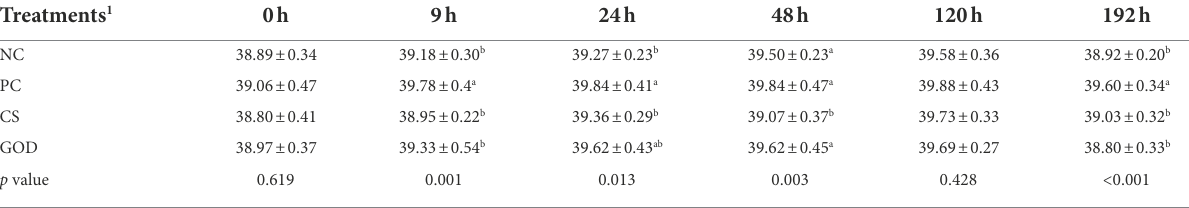
TABLE 3 Effect of dietary treatments on the rectal temperature in piglets post enterotoxigenic Escherichia coli (ETEC) challenge. Treatments